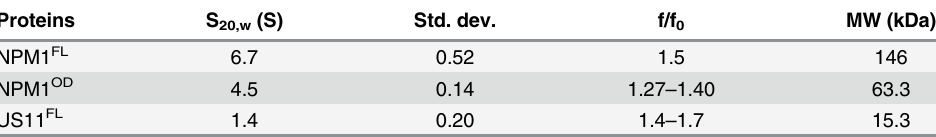
US11 FL 1.4 – 1.7 15.3 MW, molecular weight; S20,w (S), sedimentation rate at 20°C; f/f0, frictional coef fi cient. In all three cases the values refer to a single, dominant species, which represented more than 90% of the